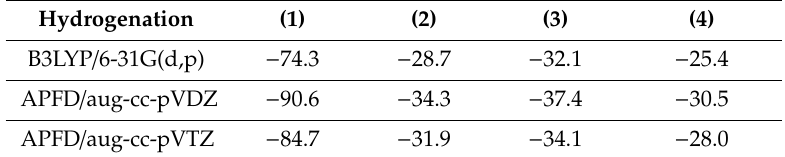
Table 11. Computed enthalpies of reaction (kcal / mol; 1.000 kcal = 4.184 kJ) for hydrogenation.